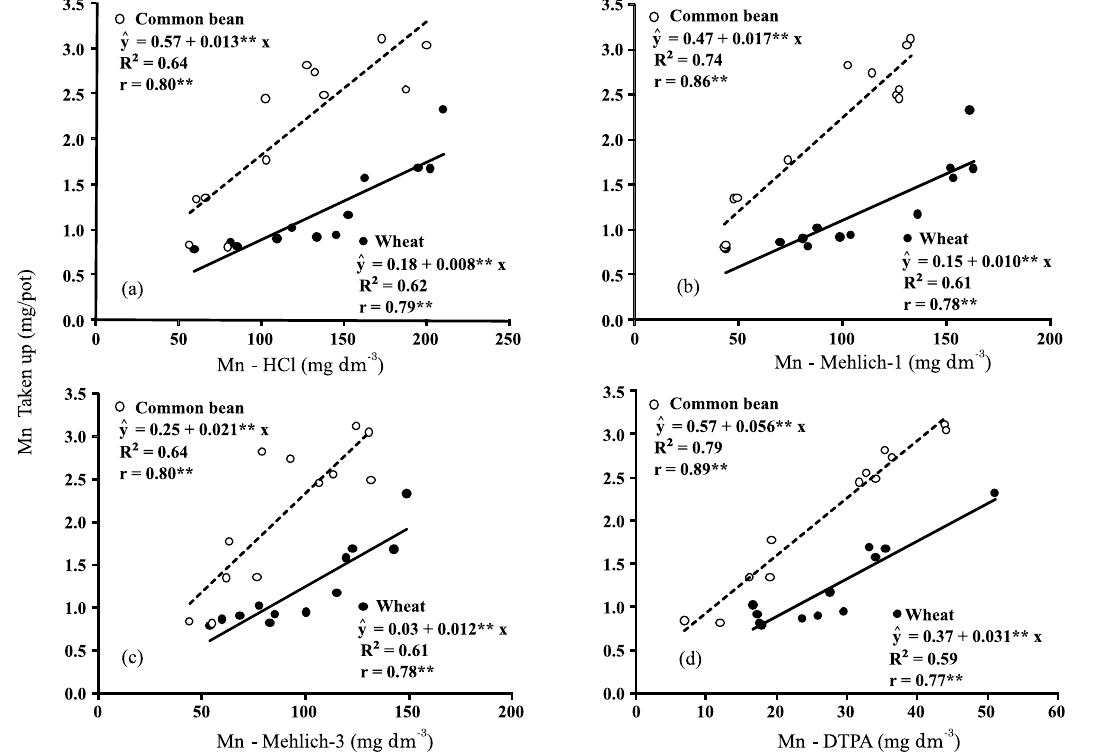
Figure 4. Relationship between the Mn contents extracted from the soil by HCl – (a), Mehlich-1 – (b), Mehlich- 3 – (c) and DTPA (d) and the quantity accumulated wheat ( ) and common bean ( ) plants, in the first and second planting period, respectively. *: p < 0.05. **: p < 0.01. (n =